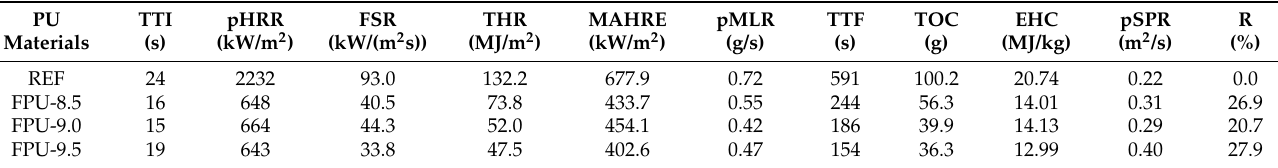
Figure 6 . ( a ) Heat release rate and ( b ) total heat release curves for obtained polyurethanes. Table 7. Cone calorimetry results, where TTI—time to ignition, pHRR—maximum heat release rate, FSR—flame spread rate, pMLR—maximum mass loss rate, THR—total heat release, MAHRE—maximum average rate of heat emission, TTF—time to flameout, TOC—total oxygen consumed, pSPR—maximum smoke production rate, EHC—effective heat of combustion of volatiles,